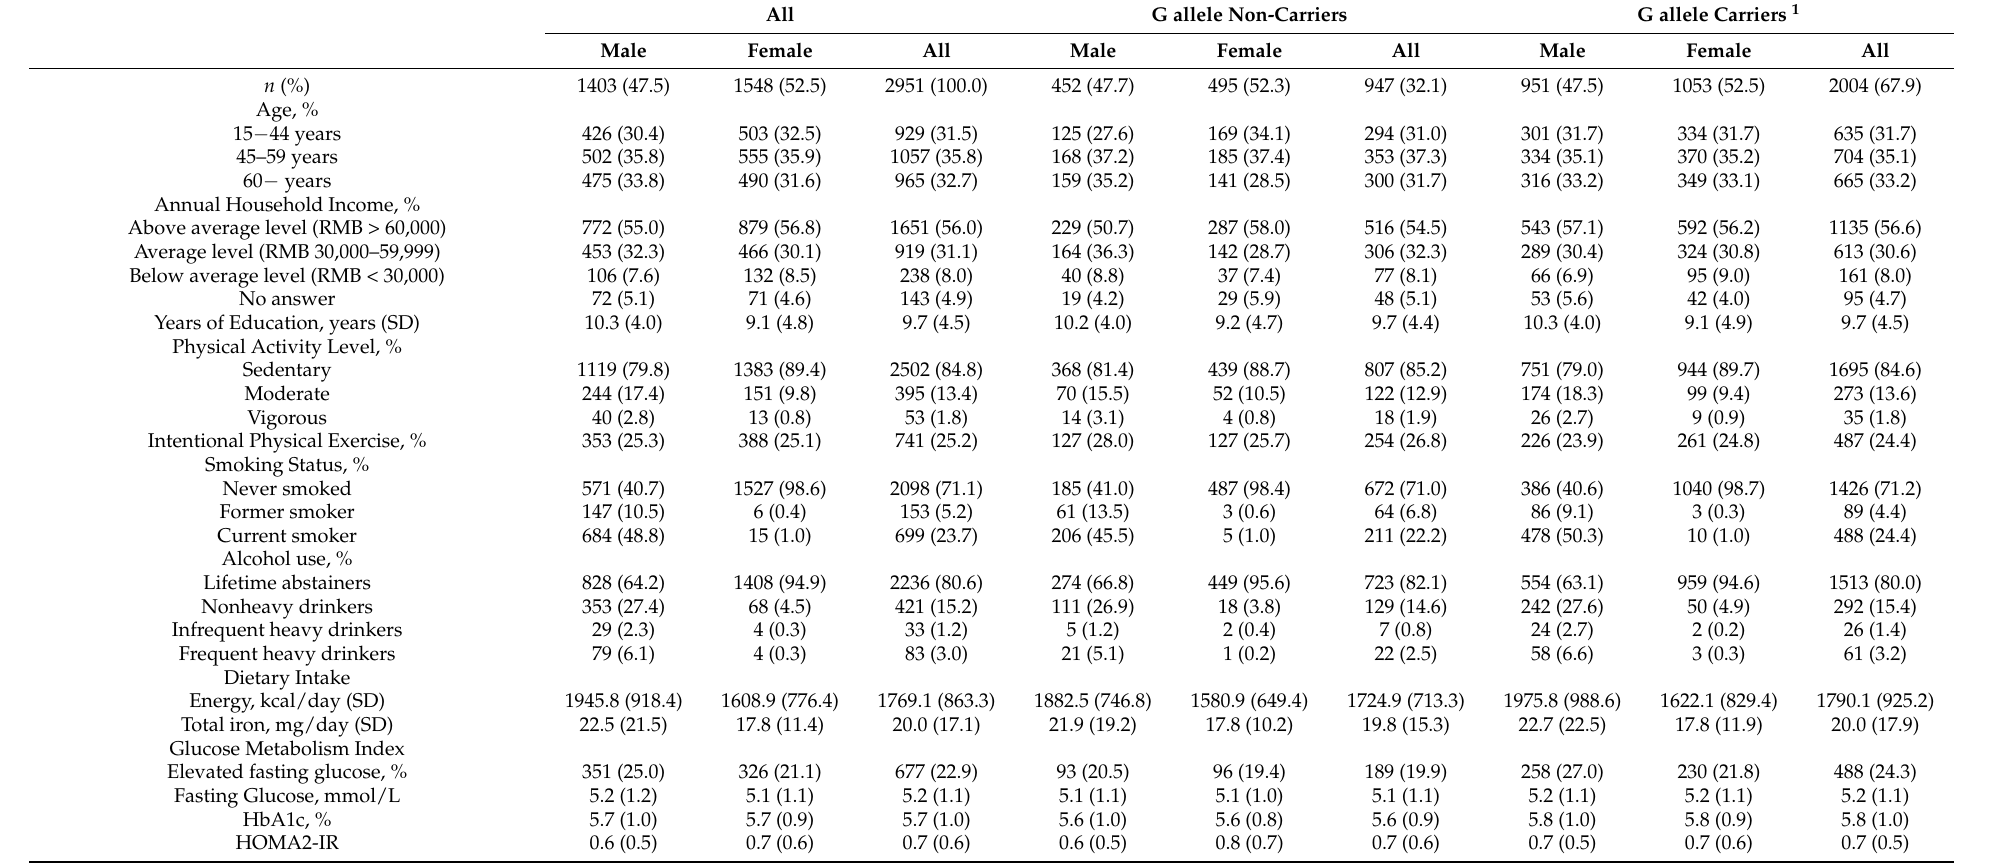
Table 1. Characteristics of the participants, stratified by G allele presence on the rs10830963 site of the gene